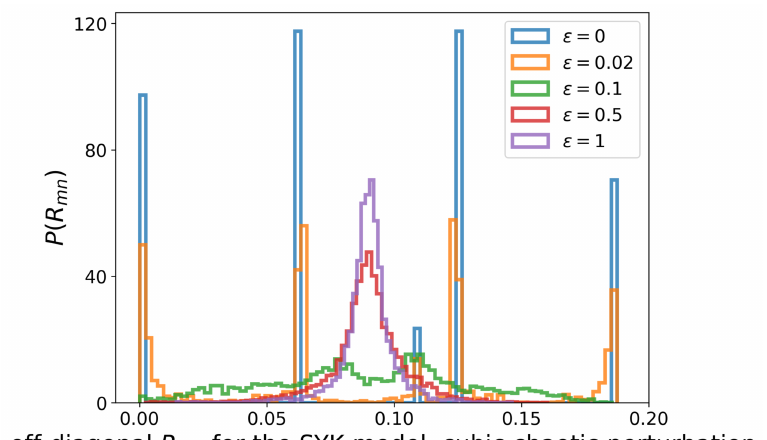
Figure 23 . The distribution of off-diagonal R mn for the SYK model with a chaotic